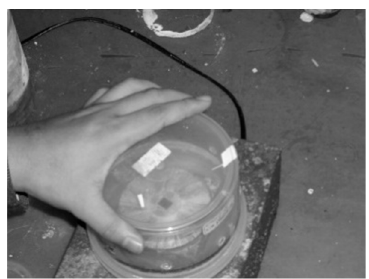
Figure 2. Process Growing the Ba0.5Sr0.5TiO3 Film Doped with RuO2.